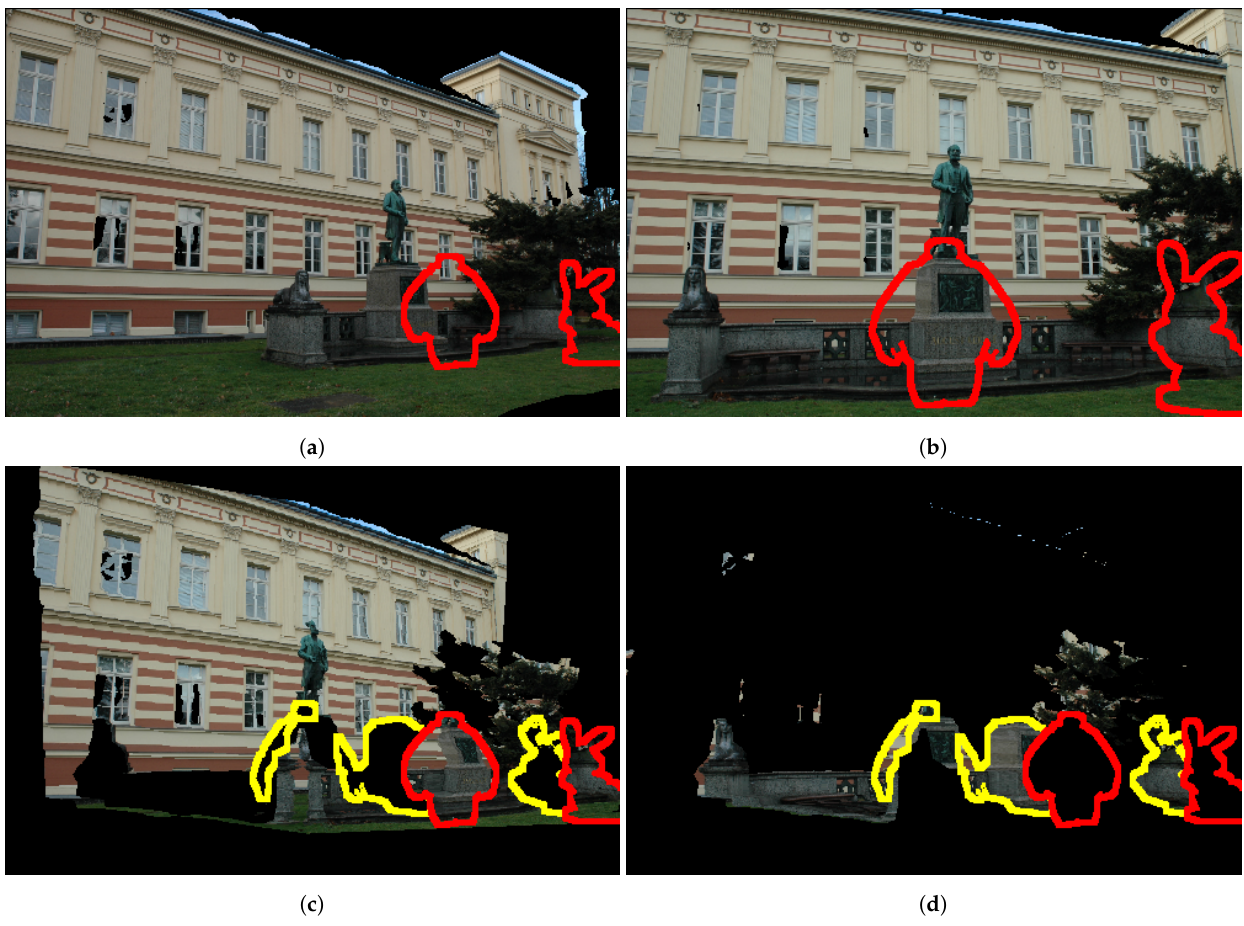
Figure 5. Reprojecting image I j on image I i (removed objects in red, corresponding occlusions in yellow). ( a ) Image I i (the sky is not in the mesh). ( b ) Image I j . ( c ) Image I j → i ( I j seen from camera C i ). ( d ) Textured shadows S j → i